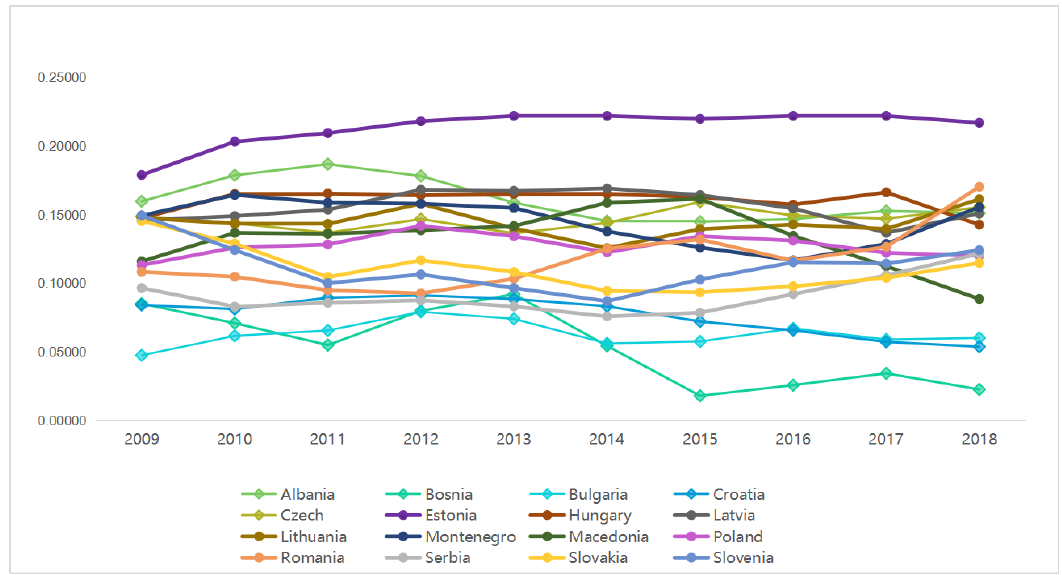
Figure 6. Evaluation results of social climate of CEE countries from 2009 to 2018.